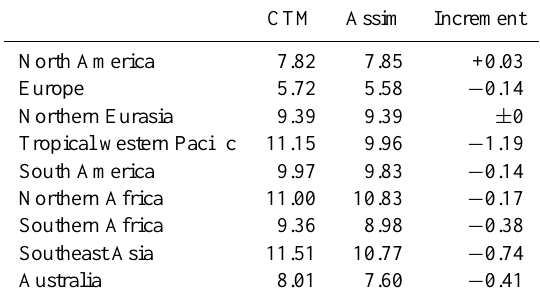
Table 3. The regional averages of the mean altitude (in km) with maximum annual LNO x emission (i.e., source peak height) esti- mated from the CTM simulation and the data assimilation and the corresponding analysis increments (the data assimilation minus the simulation). The definitions of the regions are the same as for Fig. 7, except for the tropical western Pacific (130–165 ◦ E, 1–18 ◦ N). Grid points without any LNO x sources or with peak height for pressures higher than 850hPa are removed from the average in order to mea- sure the upper tropospheric peak height. CTM Assim Increment 7.82 7.85 +0.03 −